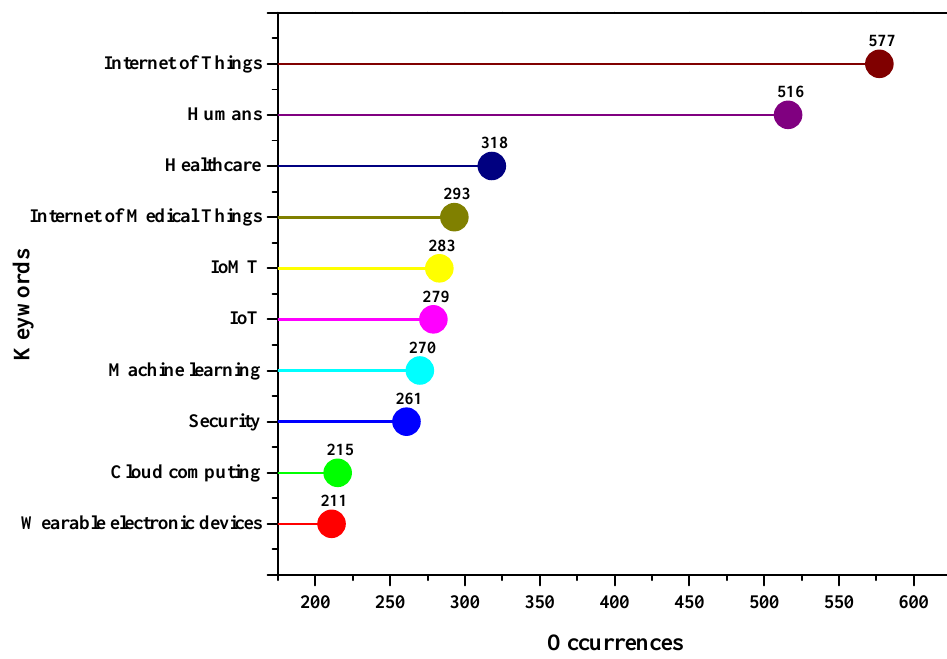
Figure 11. Most frequently used keywords in the dataset used for